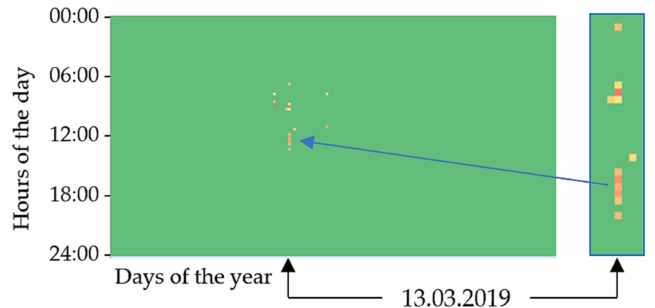
Figure 7. The matrix [hours of the day ondays of the year] for the simulation with a reduction in contractual power of 70 kW for the A2019 enterprise. The horizontal axis describes days of the year, and the vertical axis describes hours of the day. The colors of the pixels describe the power reduction level—green means no overrun, red means the largest